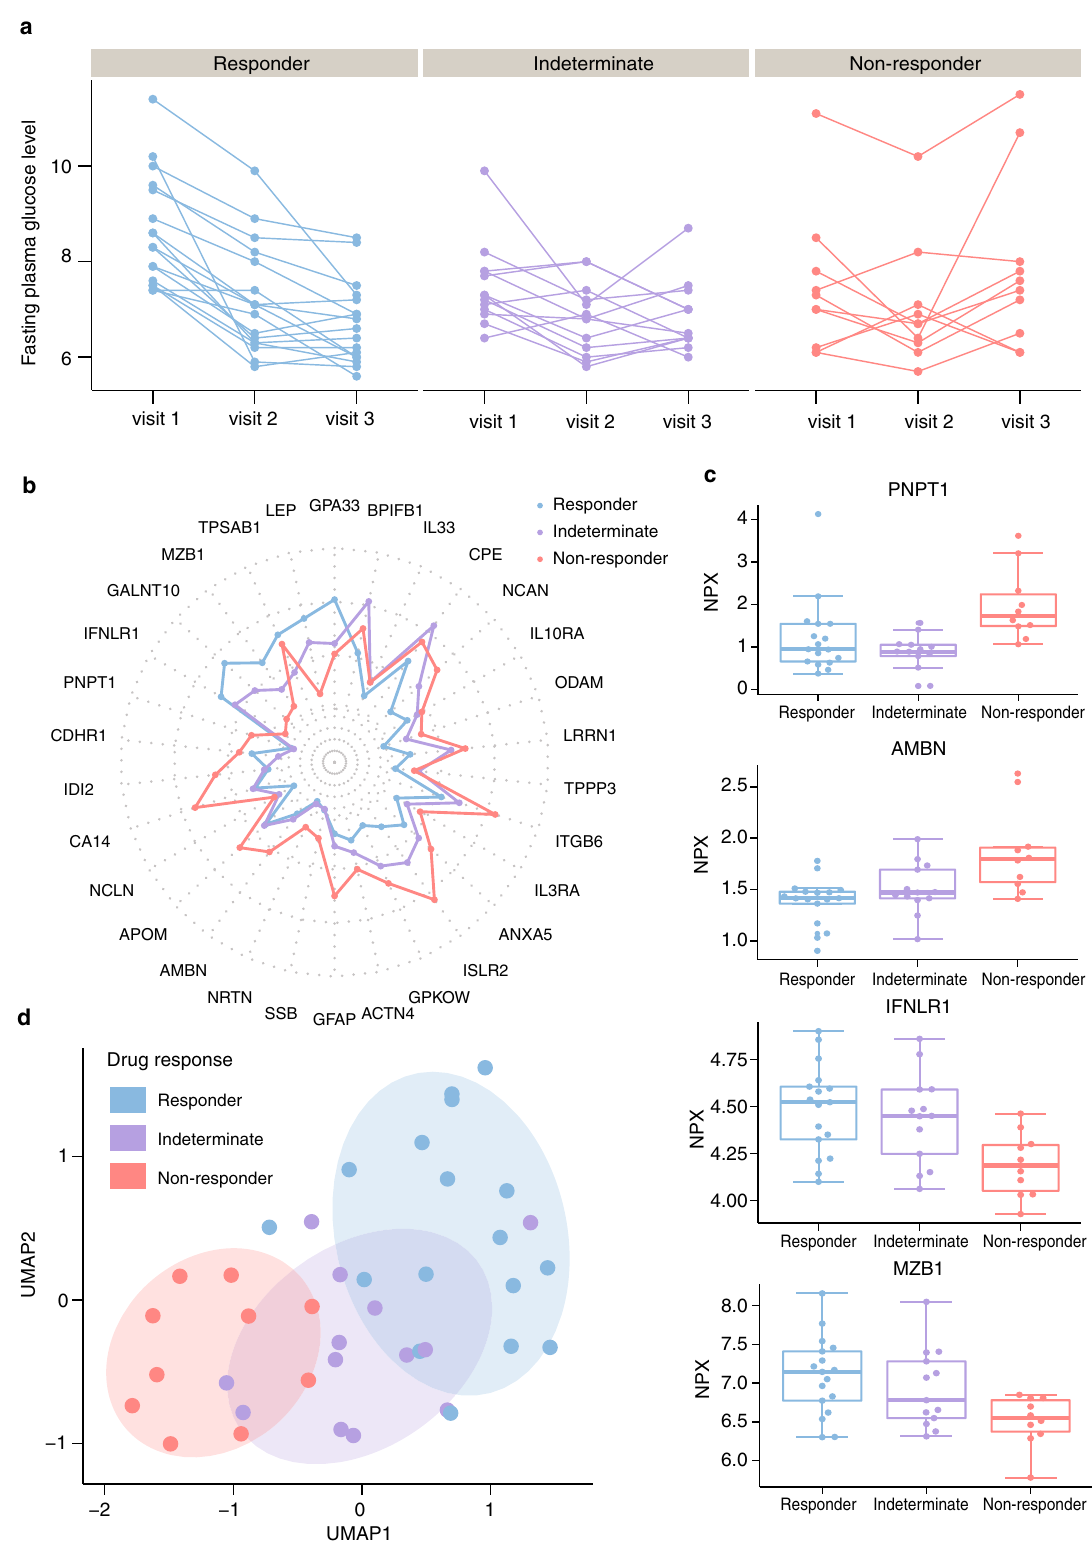
Fig. 6 Plasma proteins associated with the metformin treatment response. a The longitudinal fasting plasma glucose distribution across the three visits in T2D patients with metformin treatments. The color code indicates three different drug response groups (responder, green; indeterminate, purple; non- responder, orange). b Radar plot showing median levels of top 30 proteins associated with metformin treatment response in three groups (see expression patterns of all identi fi ed proteins in Supplementary Fig. 5). c Four examples of the distribution of the plasma levels of the most signi fi cant proteins at baseline in the three drug response groups. Box plots show medians and the 25th and 75th percentiles, whiskers show the largest and smallest values ( n = 40 samples), error bars represent mean ± SD. d A UMAP analysis of the expression patterns of T2D patients in the three drug response groups at baseline using the top 30 associated proteins. Source data are provided as a Source Data fi